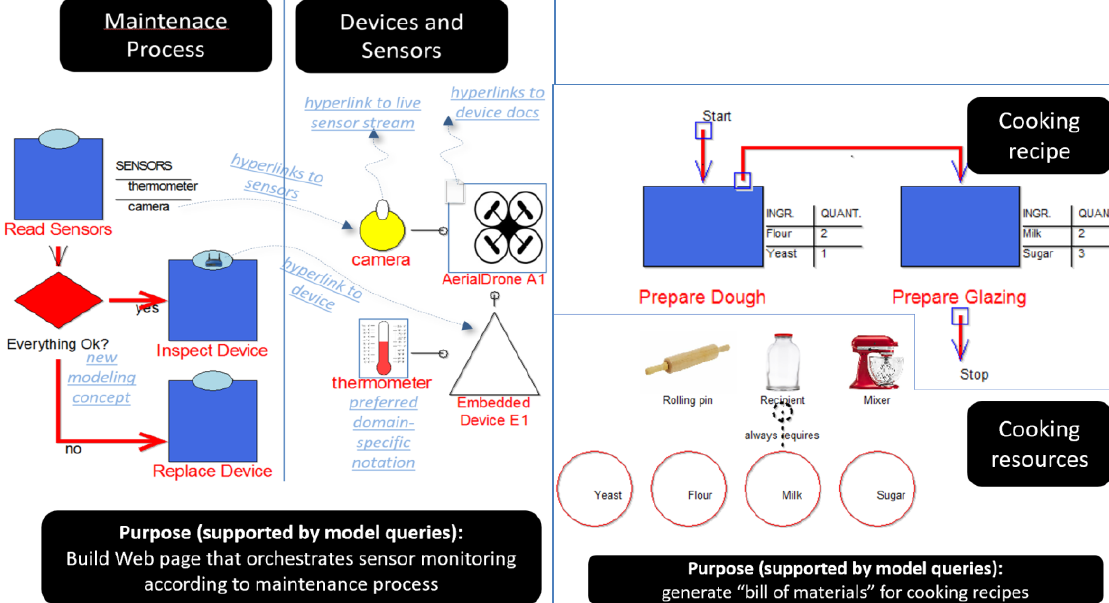
Figure 5. Model samples created with domain-specific purposeful modeling languages and tools implemented with Conceptual Modeling students (adapted from [27] and